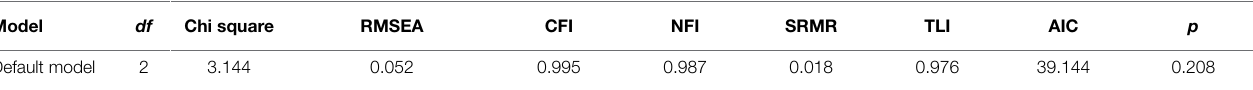
TABLE 3 | Fit indices of the CFA model of antecedents of grit. Model